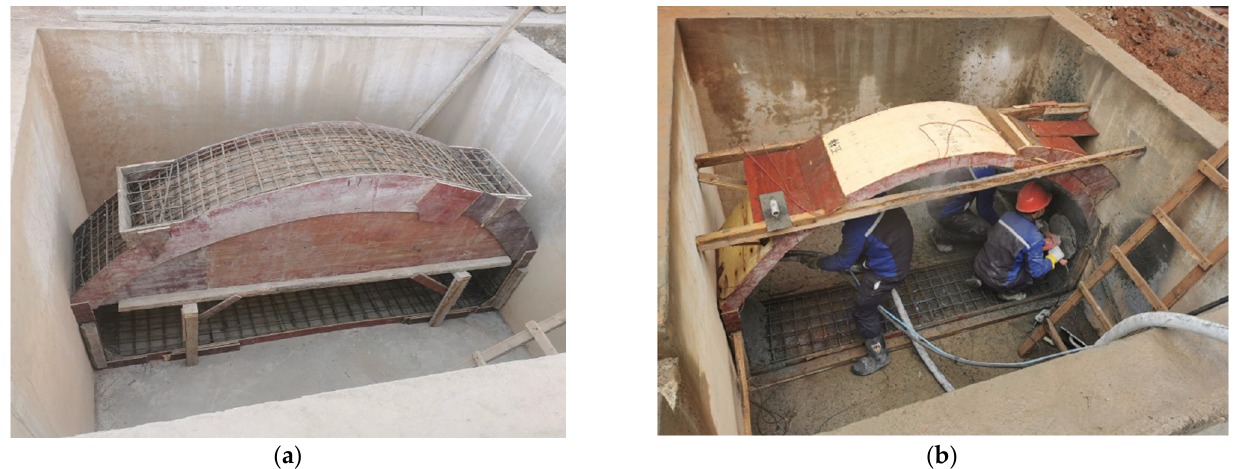
Figure 3. Test model. ( a ) assembling reinforcement; ( b ) spraying concrete.